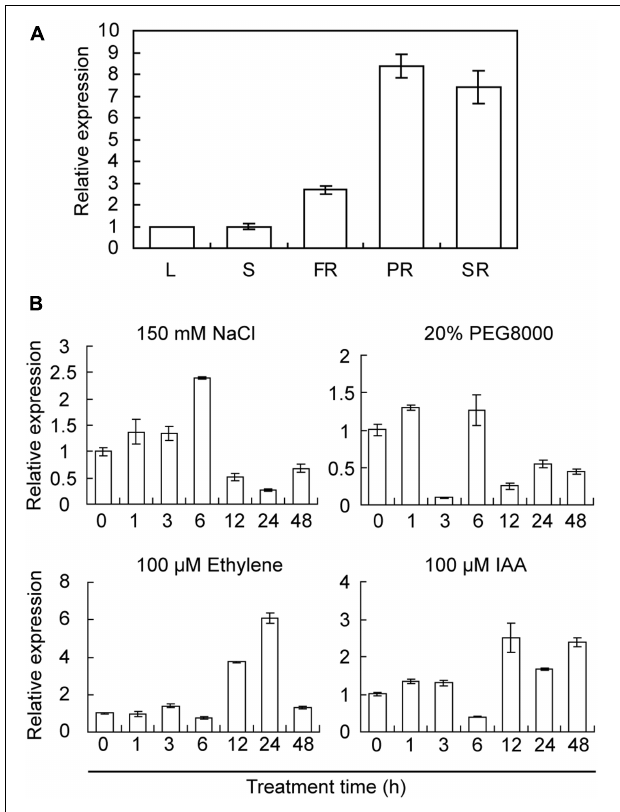
FIGURE 2 | Expression patterns of IbRAP2.4 . (A) Tissue-specific expression pattern of IbRAP2.4 . L, leaf; S, stem; FR, fibrous root; PR, pencil root; SR, storage root. (B) Expression pattern of IbRAP2.4 in responses to abiotic stresses and hormones. Data represent mean ± standard deviation (SD) of three biological